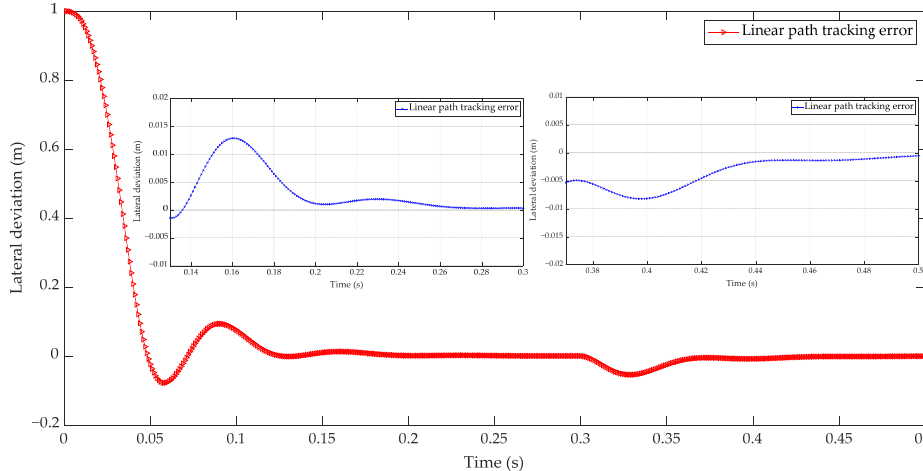
Figure 14. Lateral deviation control curve of linear path tracking.